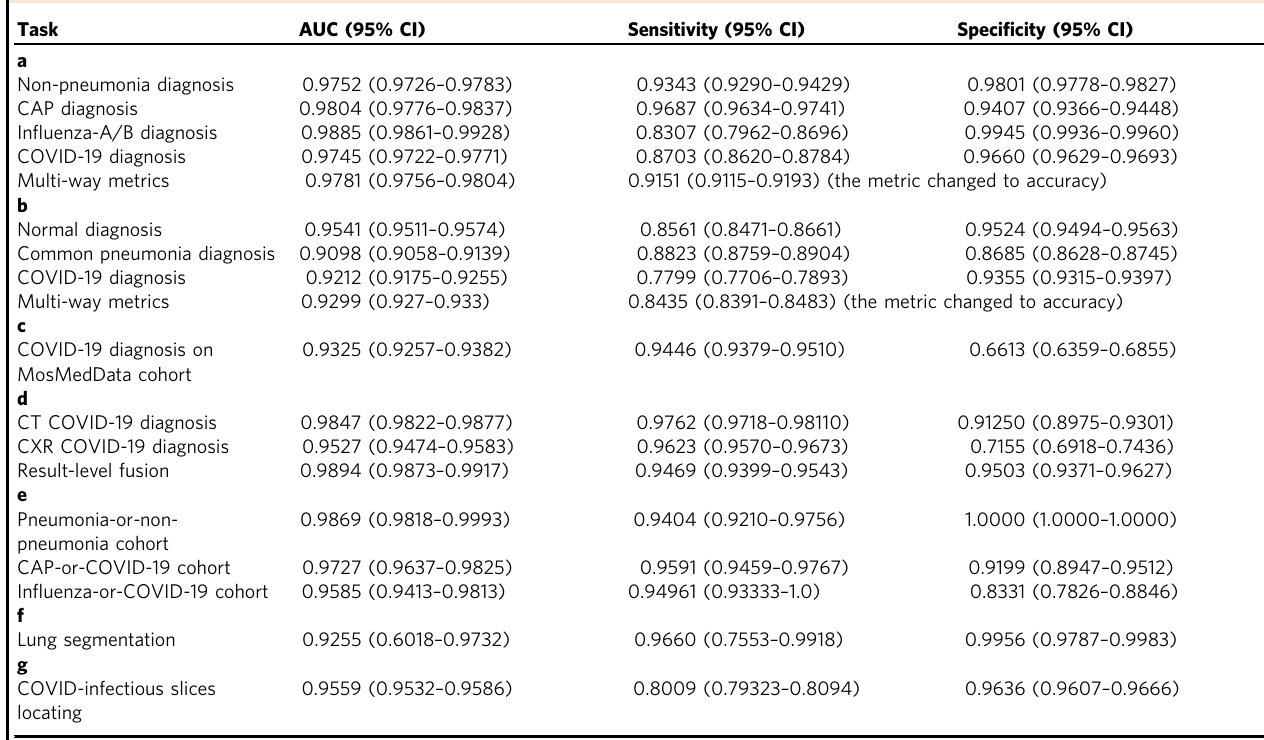
Table 2 Metrics of the AI